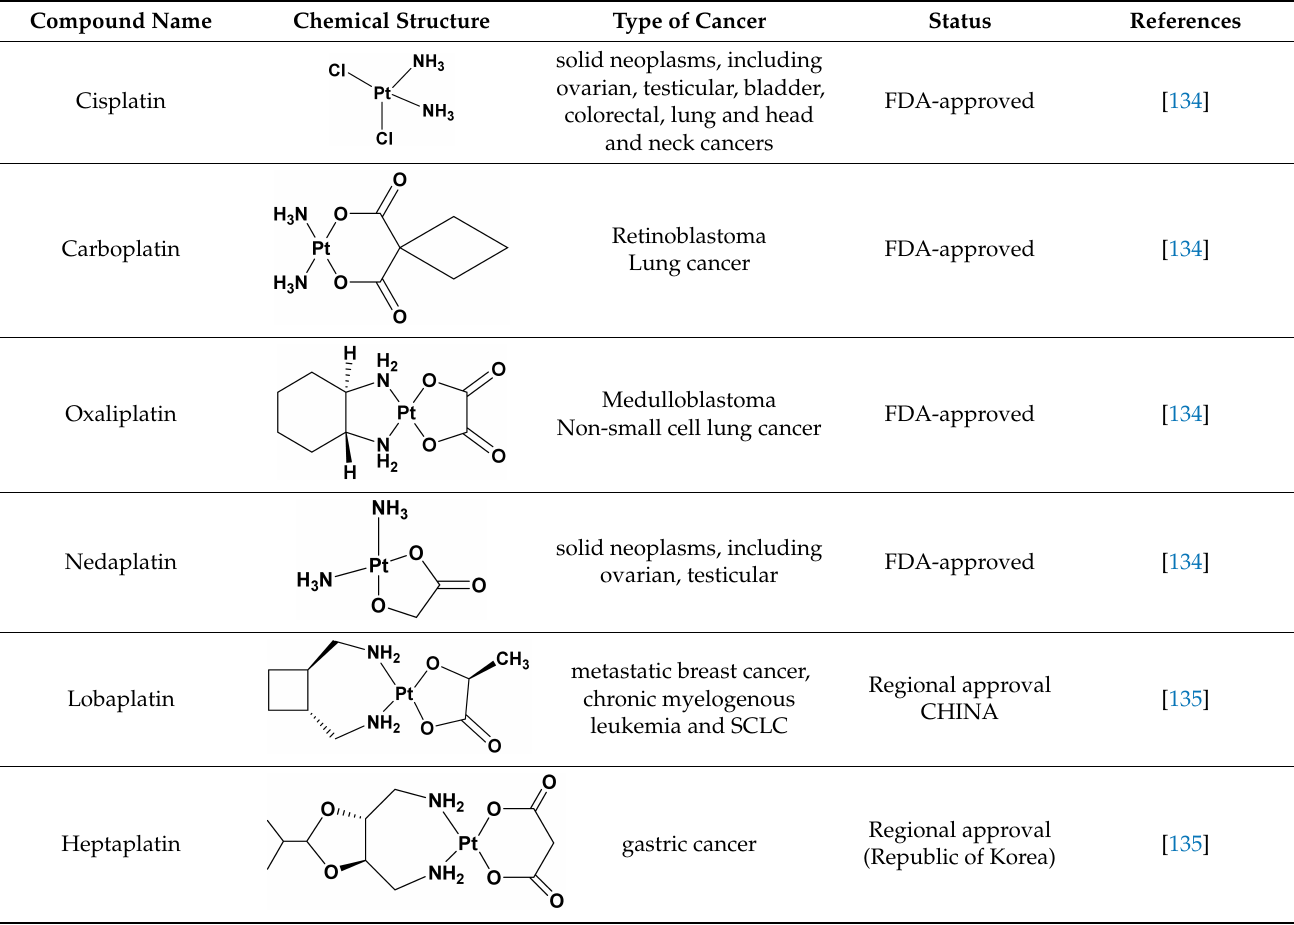
Table 54. Platinum-based anticancer drugs with chemical structure, specific cancer types and cur- rent